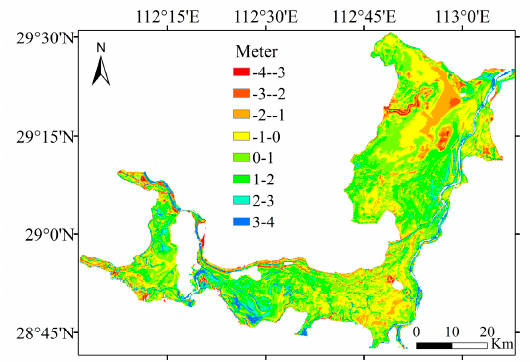
Figure 18. Distribution of the difference in the water level between the kriging and measured elevation grid models.